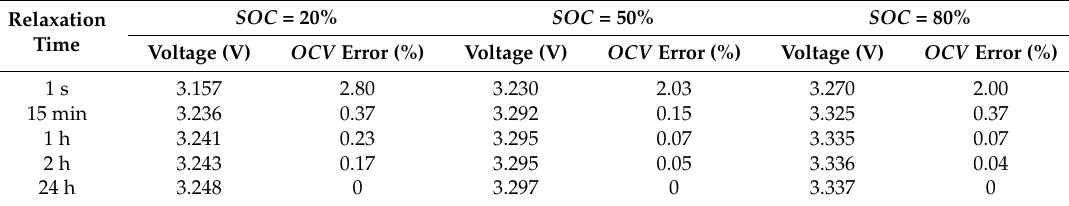
Table 1. Voltage measured at 20%, 50%, and 80% SOC after various relaxation time periods and corresponding OCV errors.